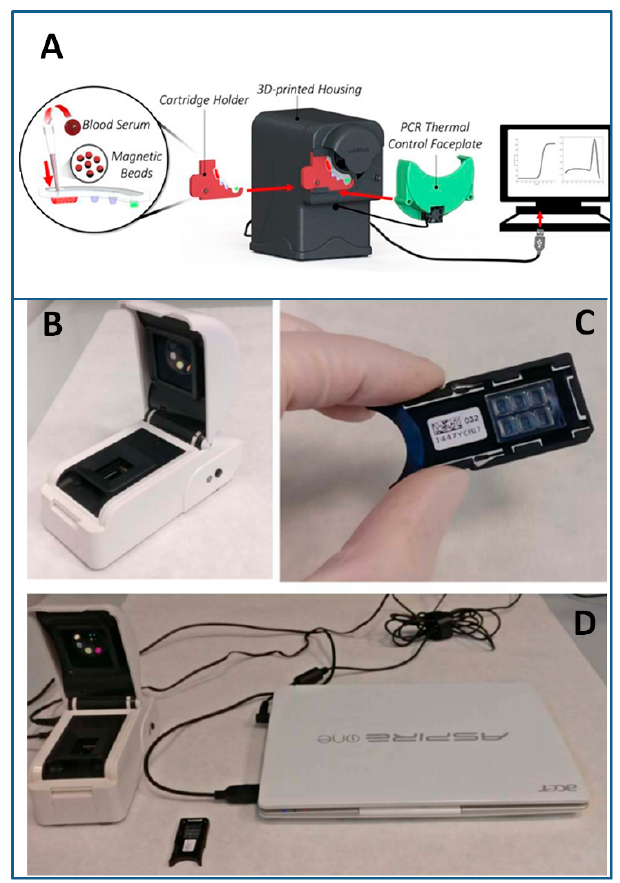
Figure 11. ( A ) A sample-to-answer qRT-PCR system for the detection of RNA from Hepatitis C virus (HCV) developed by Shin and co-workers using a droplet magnetofluidics tool in plastic cartridges [217]; ( B – D ) Q3 compact platform developed by Biava and co-workers for the real-time detection of viral nucleic acids extracted from plasma, urine, and oral swabs. Reproduced with permission from reference [220].